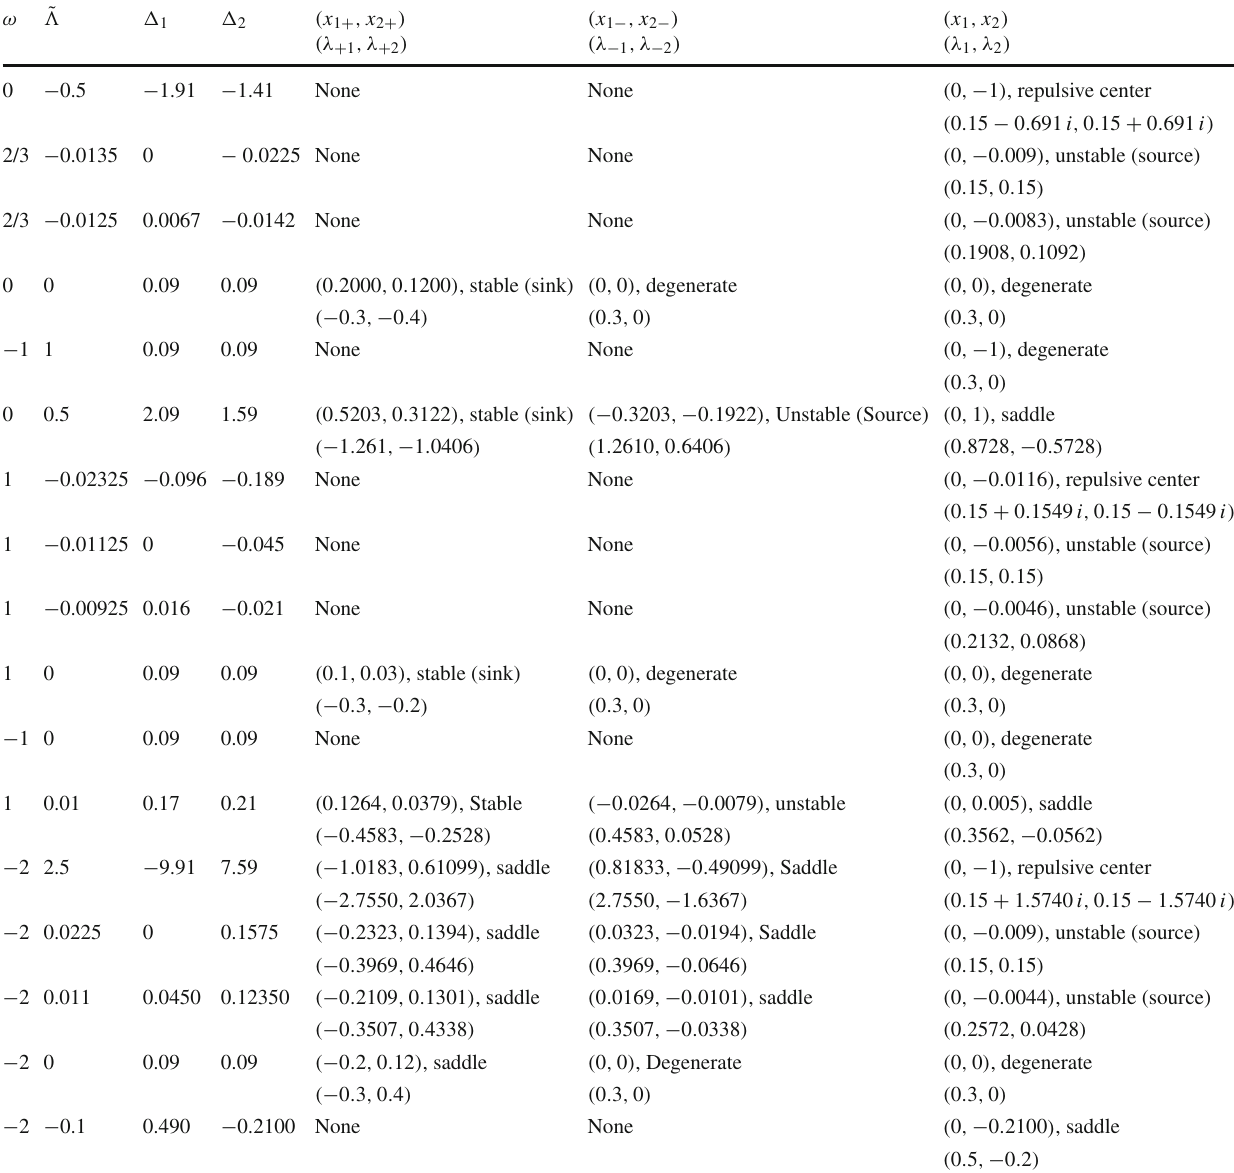
Table1 Resultsfortherepresentativecasesofhavingalonefixedpoint along the x 2 axis but with also including the possible ones along the flat curve solution if they arise. The first set are for ω = 0 , 2 / 3 and − 1 with suitably chosen value of ˜ (cid:4) to have a clear appearance of the fixed point along the x 2 axis. The last two sets are respectively for ω = 1 and ω = − 2 and exhibiting all possible scenarios for the fixed point along